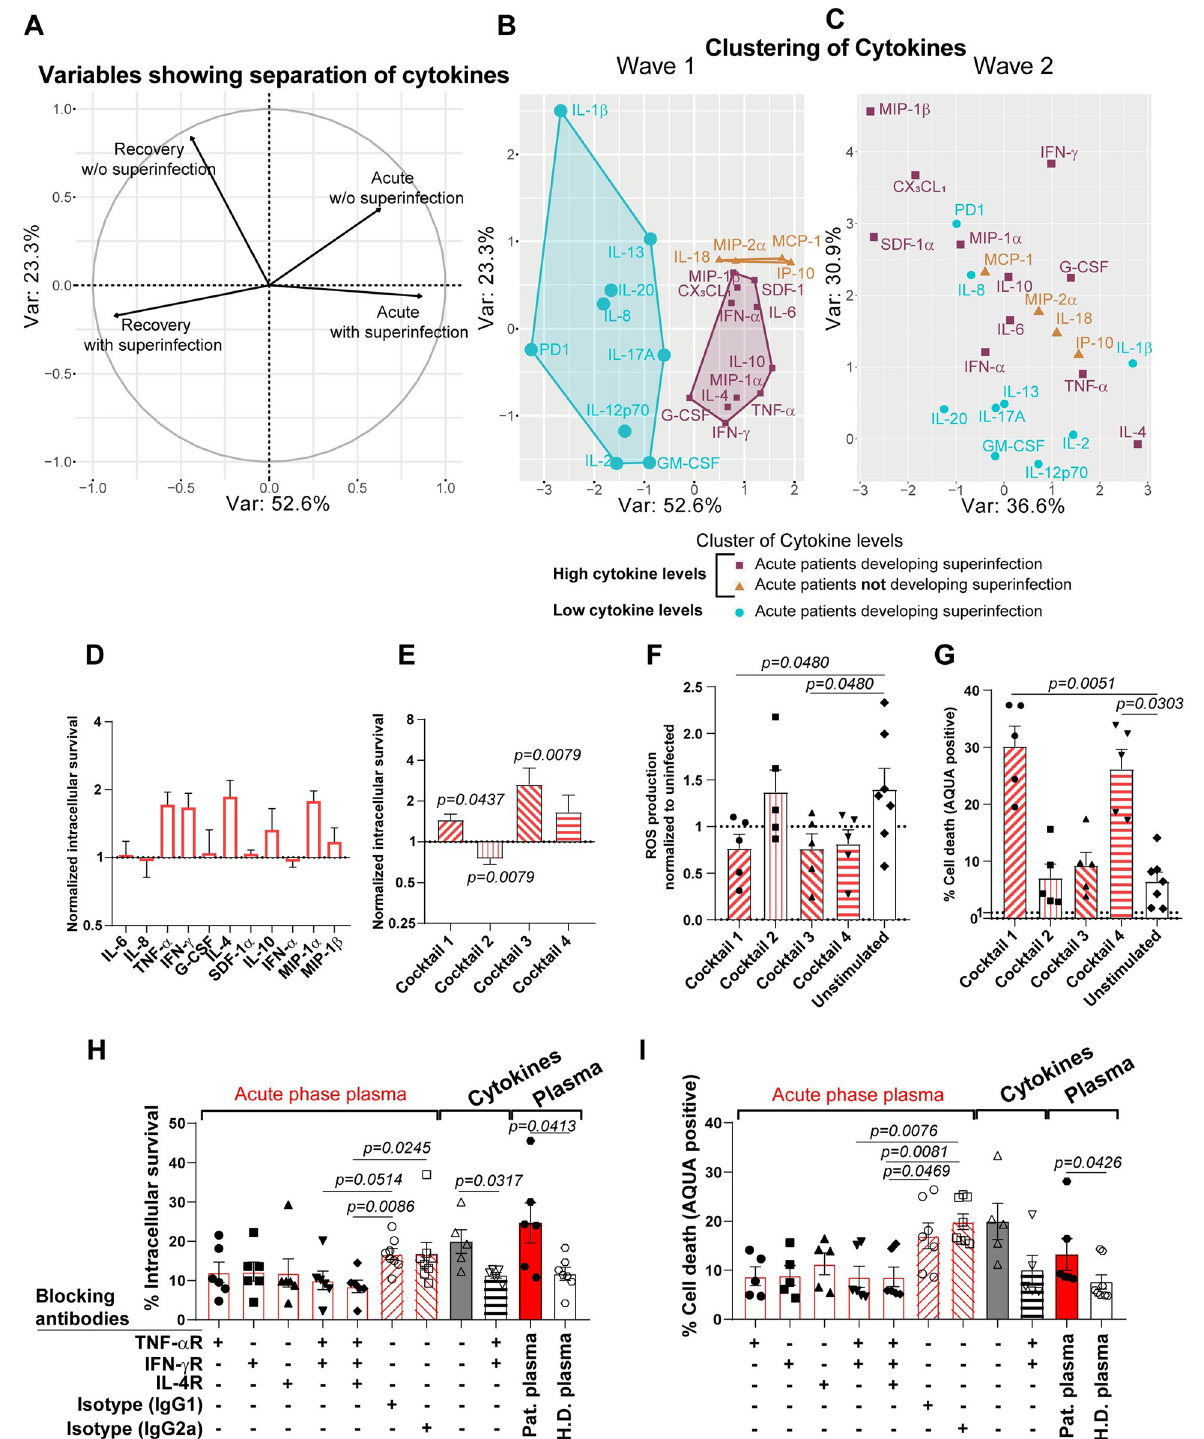
Fig 7. Plasma cytokine levels quantification of COVID-19 patients according to superinfection status and functional cytokine analysis. (A) PCA of cytokine levels in COVID-19 patients with secondary bacterial infections (superinfection) vs COVID-19 patients without superinfection, showing the separation axis between acute- and rec-phase. (B and C) PCA of plasma cytokine level comparison between acute- and rec-phase of wave 1 and wave 2 patients highlighting a cluster of elevated levels of cytokines in COVID-19 patients with superinfection (purple), cluster with elevated levels of cytokines in COVID-19 patients without superinfection (orange) and cluster with similarly low levels in acute- and rec-phase in